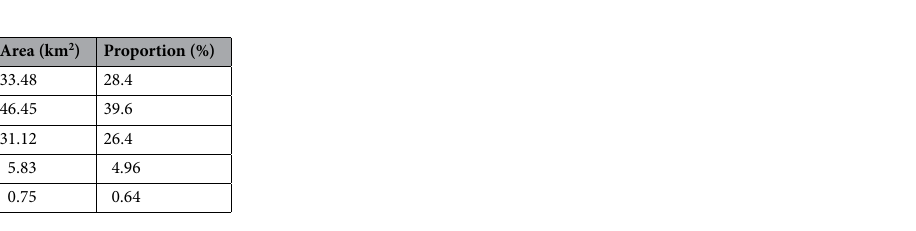
Table 9. Statistical area and proportion of each grade of the previously mined area of Ili No.4 Coal Mine.